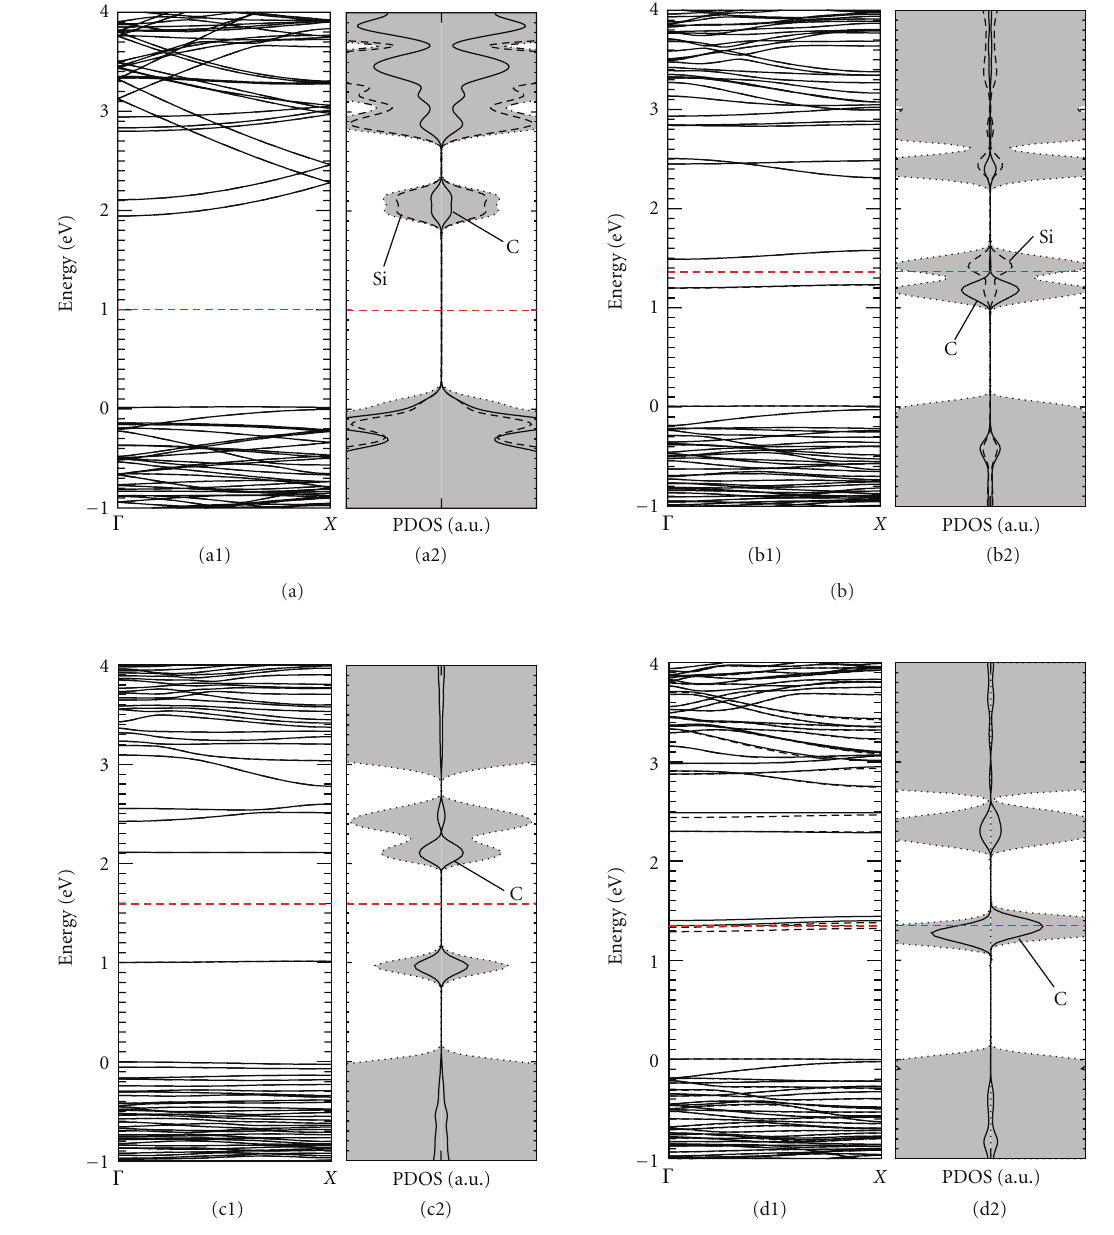
Figure 5: (Color online) Electronic band structure and the projected density of states (PDOS) of Si-coated [100] SiC NW. (a) Pristine NW, and with the presence of defects, (b) C–Si, (c) 2(C–C) Si , and (d) C–C Si . In the PDOS diagrams, the shaded regions correspond to the total density of states; in the electronic band structure diagrams, solid lines (dotted lines) represent the spin-up (spin-down) electronic channels. The red dashed lines correspond to the position of the Fermi level and the zero energy corresponds to the valence band maximum.